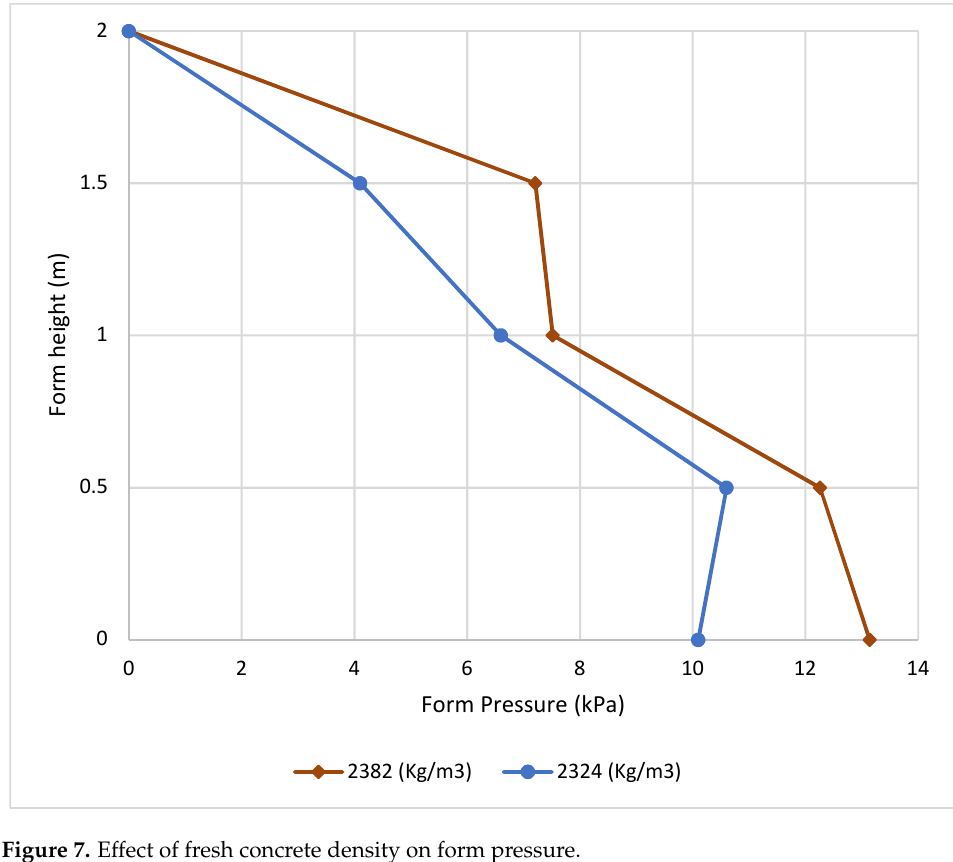
Figure 7. Effect of fresh concrete density on form pressure.